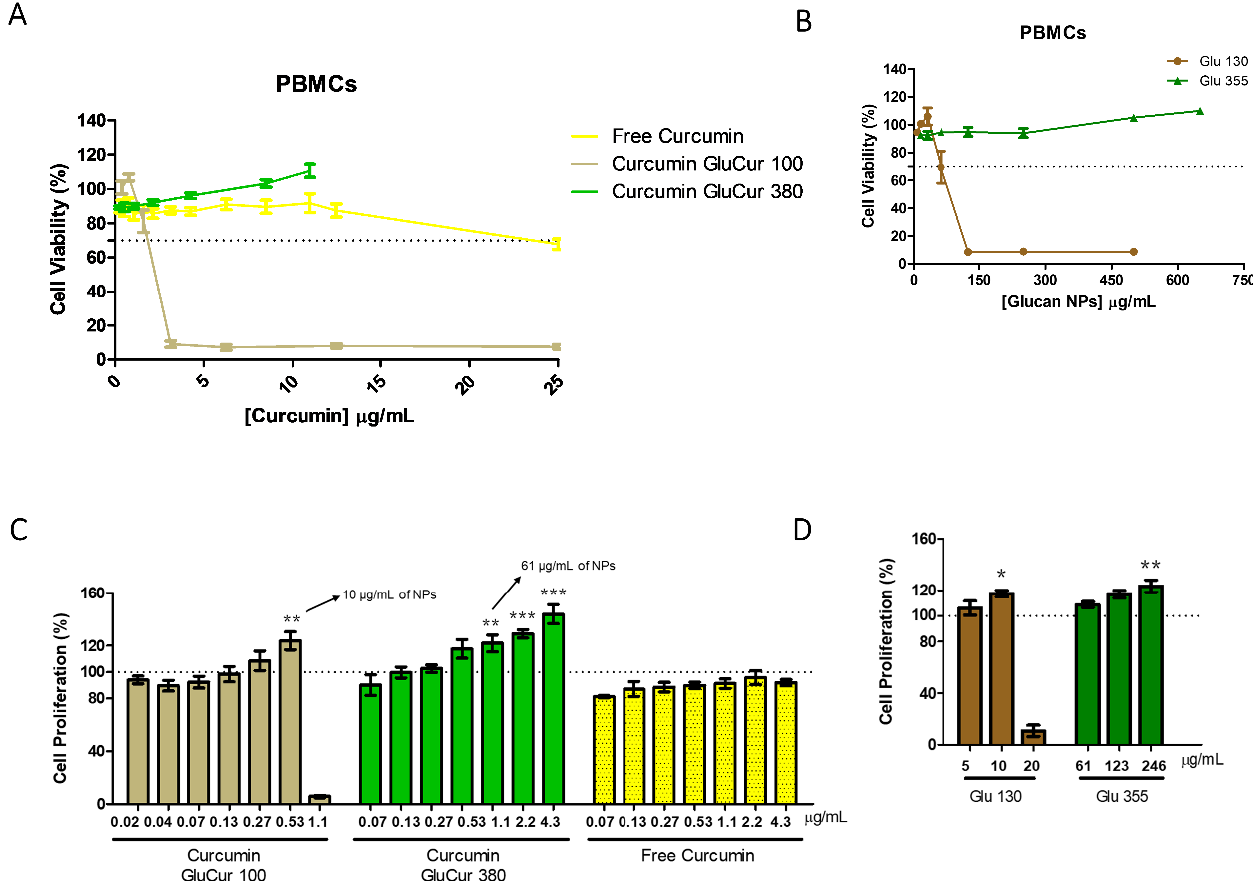
Figure 4. Cytotoxicity effect of curcumin-loaded glucan NPs and free curcumin on human PBMCs. Cell viability was evaluated with the MTT assay after an incubation period of 24 h with increasing concentrations of free drug, GluCur 100, GluCur 380 NPs ( A ), and the unloaded glucan NPs (blank NPs) ( B ) (mean ± SEM, n = 5, five independent experiments, each in triplicate). ( C ) Cell proliferation induced by different concentrations of free curcumin (0.07–4.3 µ g/mL) and curcumin associated with GluCur 380 (0.07–4.3 µ g/mL) and GluCur 100 NPs (0.02–1.1 µ g/mL) after incubation with cells for 72 h and subsequently measured by the MTT assay. Blank NPs were also tested in the same conditions ( D ). Cell culture medium was used as the control (mean ± SEM, n = 4, four independent experiments, each in triplicate). * p < 0.05, ** p < 0.01, *** p < 0.001, when values were significantly different from the